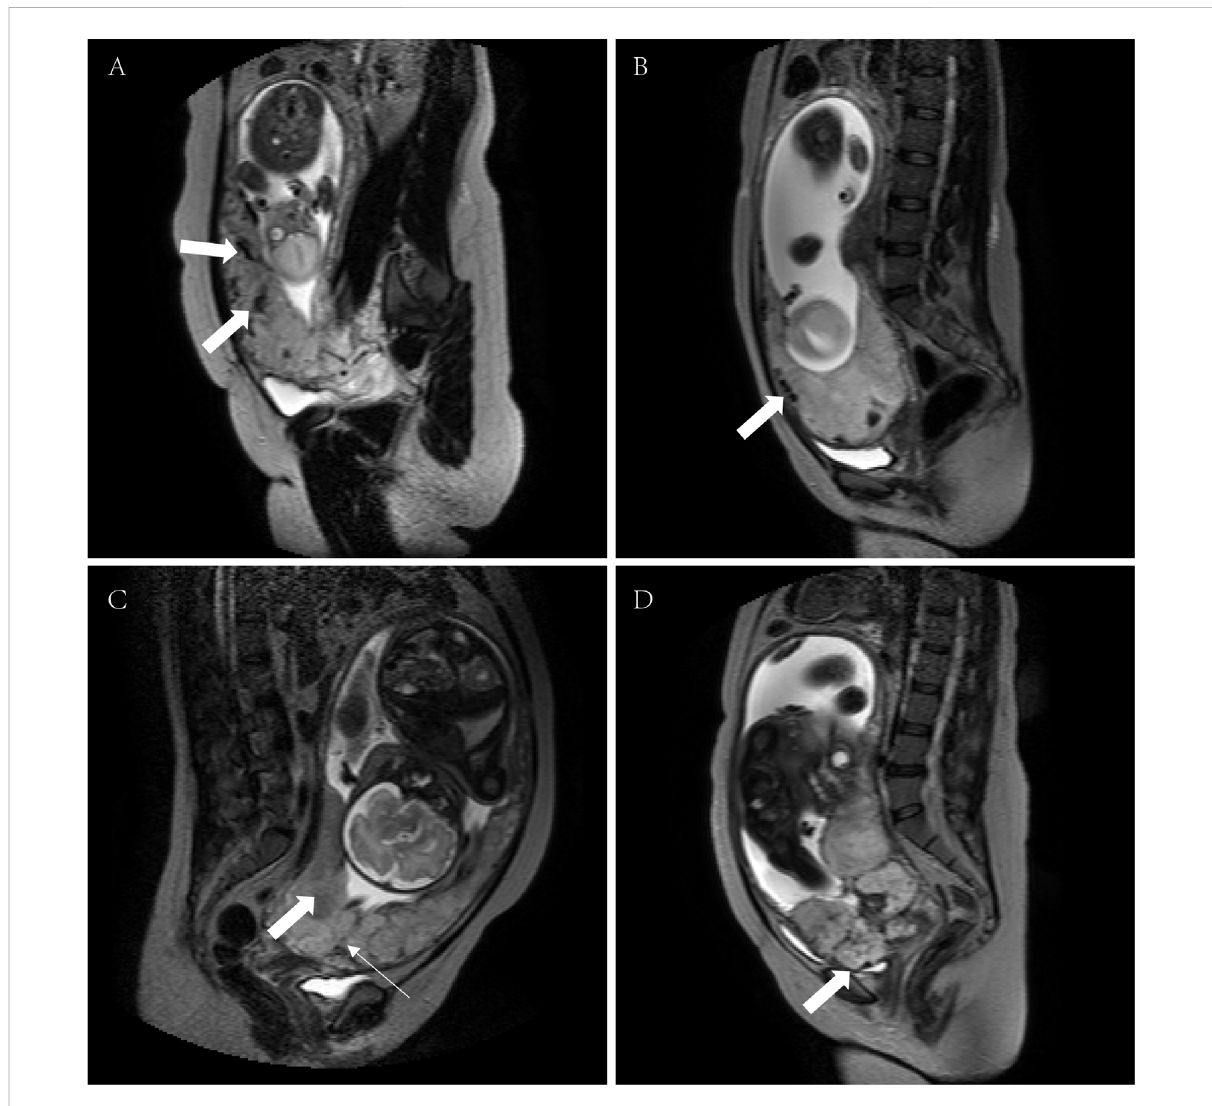
FIGURE 2 MRIsignsassociated withPPP (T2WIand sSSh-TSE sequences). (A) Intraplacental abnormalvascularity(arrows), (B) abnormalvascularizationof theplacental bed(arrow); (C) heterogeneousplacenta(broadarrow)with adark bandon T2WI(narrowarrow);and (D) serosalsurfaceofthebladder disruption (arrow). MRI, magnetic resonance imaging; PPP, pernicious placenta previa; T2WI, T2-weighted imaging; sSSh-TSE, Sense single-shot turbo spin